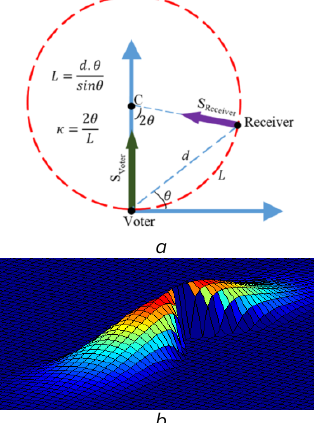
b Figure 1. Stick voting. a) Vote casting from “Voter” token